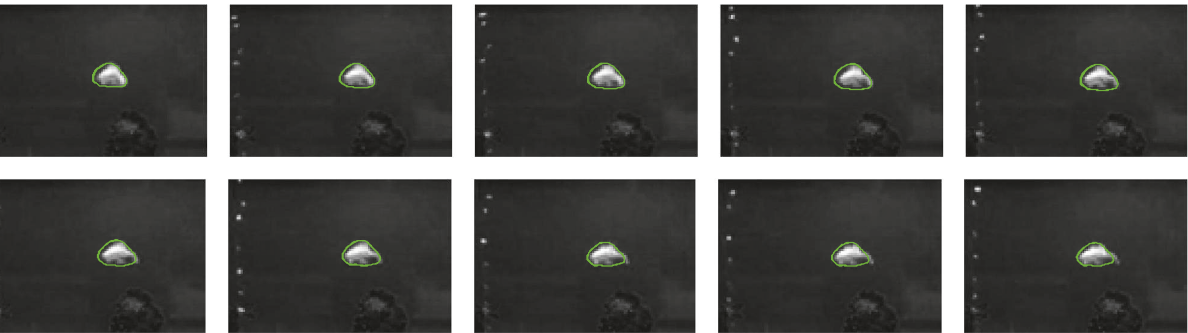
Figure 7: The results of segmentation with the parametric C-V model.